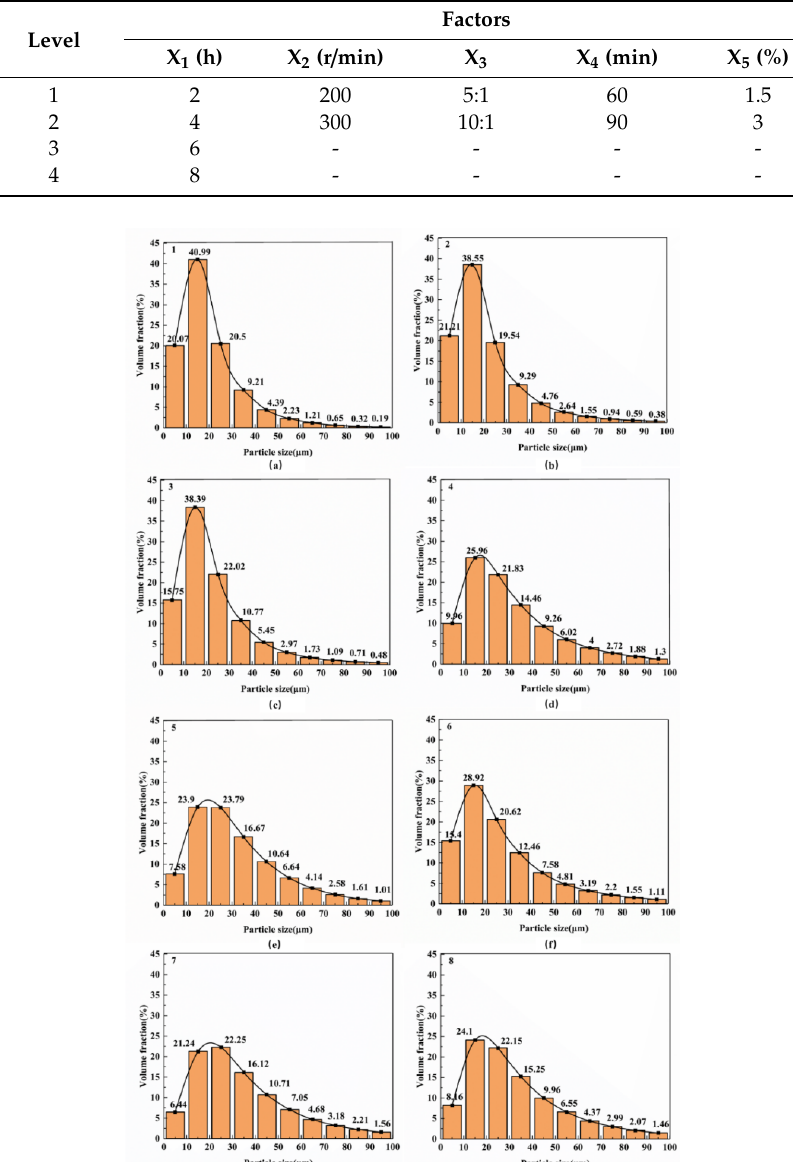
Table 2. Factors in the orthogonal test and their levels.